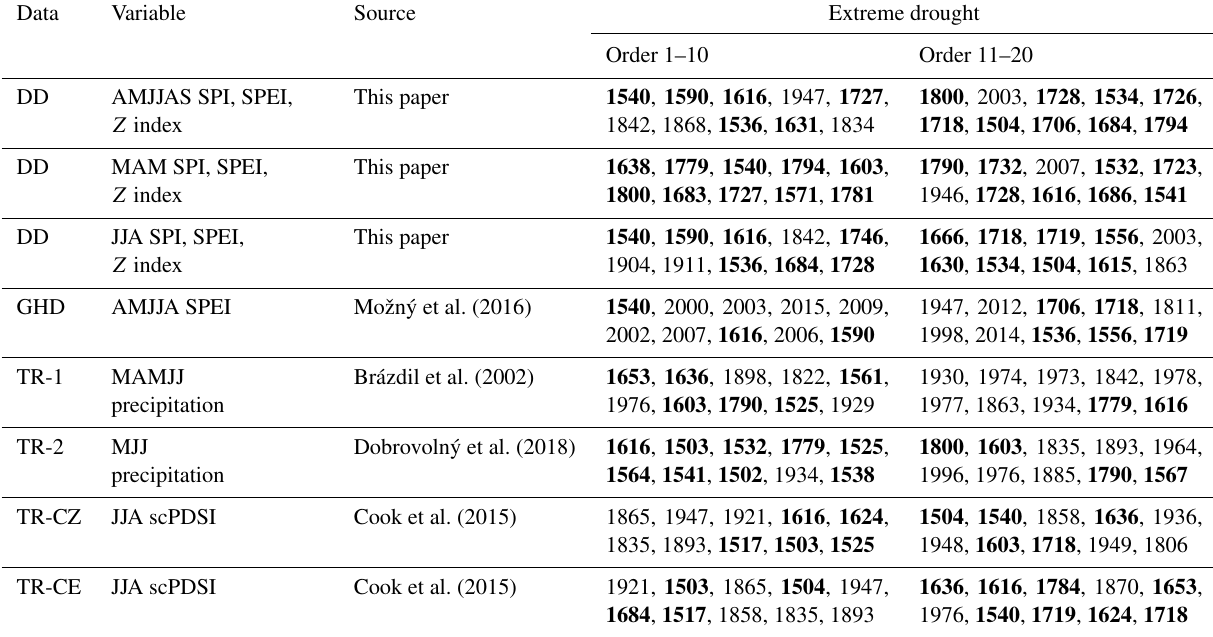
Table 2. Comparison of selected extreme years for the Czech Lands from drought indices based on documentary data (DD) in this paper with those selected from AMJJA SPEI based on grape harvest dates (GHD) in Bohemia, MAMJJ precipitation in South Moravia based on fir tree rings (TR-1), MJJ precipitation in Bohemia based on oak tree rings (TR-2), JJA scPDSI in the Czech Republic (TR-CZ) based on tree rings and JJA scPDSI in central Europe (TR-CE) based on tree rings. Years of the extreme droughts in the pre-instrumental period appear in